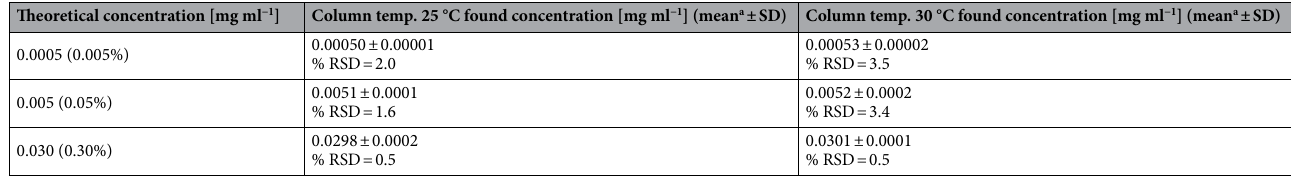
Table 5. Robustness. a Mean value of three independent